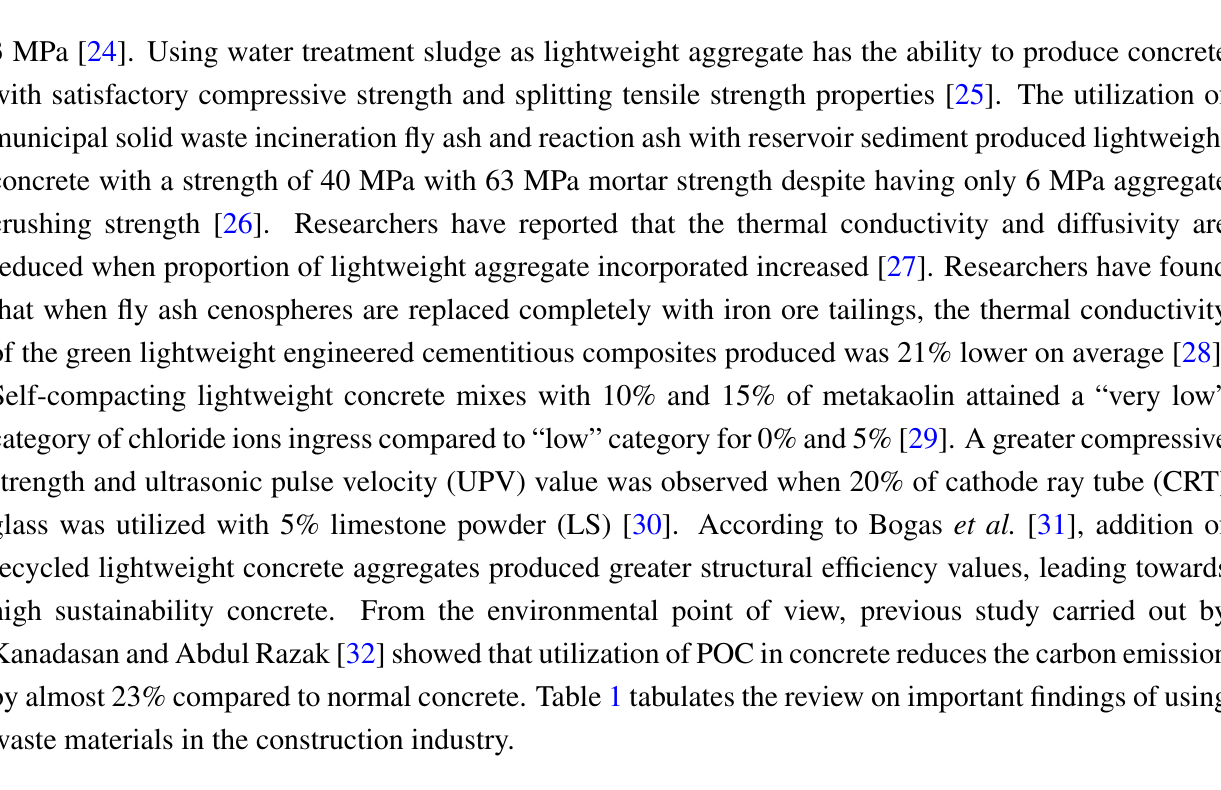
Table 1. Review on important findings of using waste materials in the construction